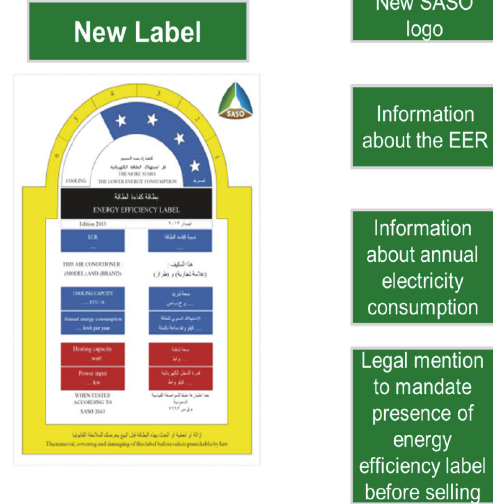
Table 3: Star rating of air-conditioner quality.